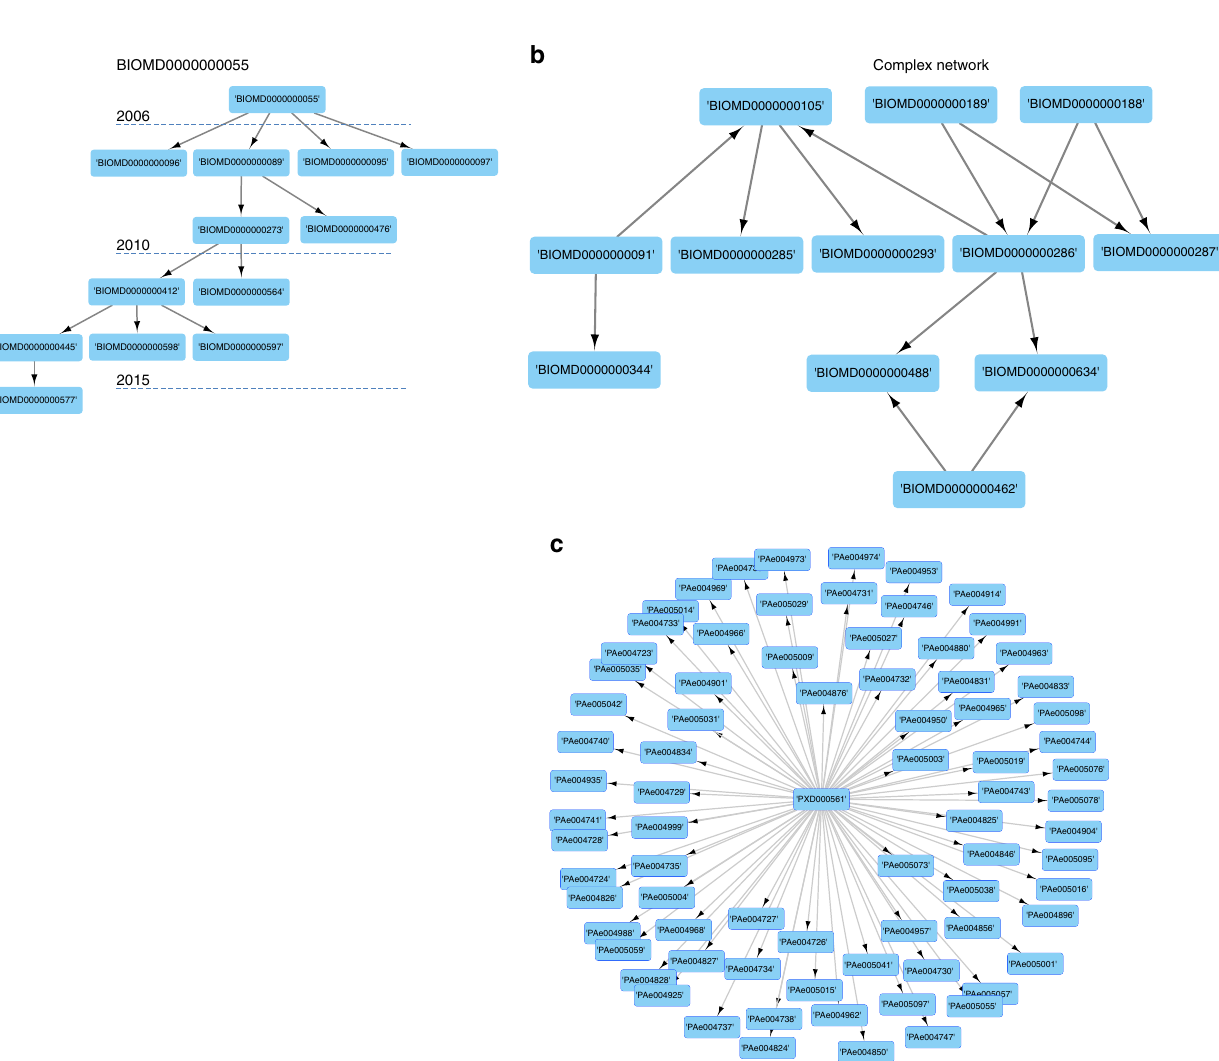
Fig. 1 Examples of the reanalysis network for different OmicsDI datasets: a BioModels model BIOMD0000000055. BioModels are reused over time (e.g. 2006 – 2015) to build new models; in the BioModel database each new model contains references to the original source model of information. b Twelve different BioModels models are connected through a reanalysis network. The BioModel database traces the origin of each model and the relations between them, enabling to trace complex reanalysis relations where models can be originated from multiple models and be used by other models. c Proteomics reanalysis network for the draft of the human proteome project (PRIDE accession PXD000561). In proteomics, the predominant reanalysis pattern is “ one to many ” , where original deposited submissions are reanalysed in multiple datasets by multiple